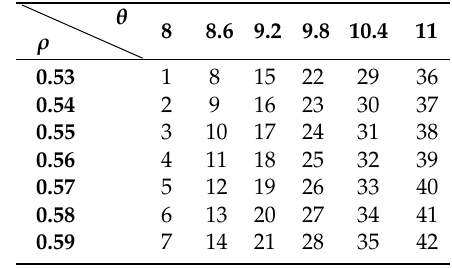
Table 4. Correlation coefficient ( r ) between satellite measurements and model results. The correlation coefficient r is related to the covariance of the whitecap coverage. The first row are the values for θ while the first column are the values for ρ . The significant level is 0.05. The critical value is 0.062. r ρ